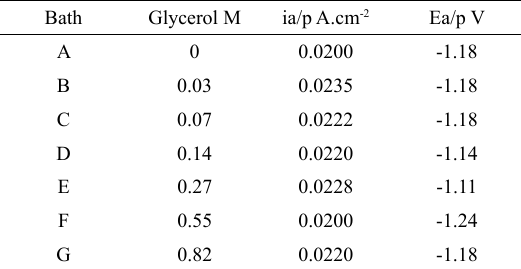
Table 7. Current and potential density data at the peak of active / passive transition